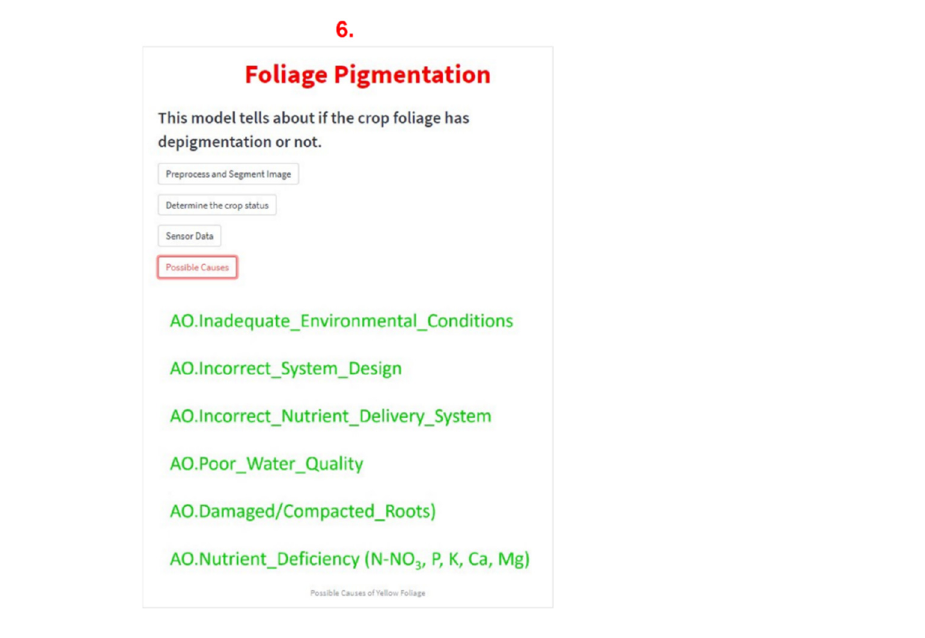
Figure A2. Stages 3 and 4 of cloud-based application. Figure A3. Stage 5 of cloud-based application.